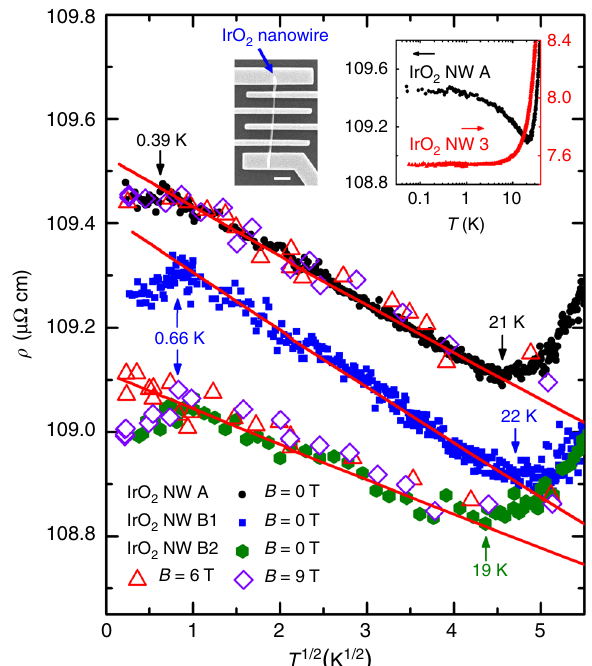
ffiffiffi p T for IrO 2 NWs A,